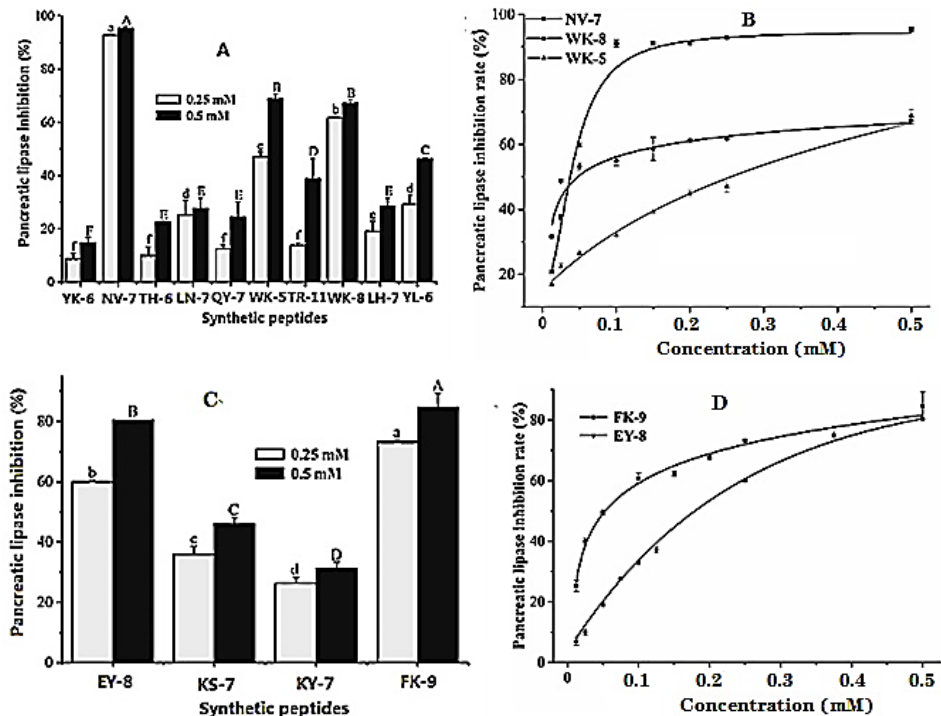
Figure 2. Inhibitory effects and IC50 calculation curves of synthetic peptides identified from hy- drolysates ( A , B ) and the hydrolysates after ultrafiltration affinity chromatography ( C , D ) to pancreatic lipase. Different letters in the figure represent significant for different groups.